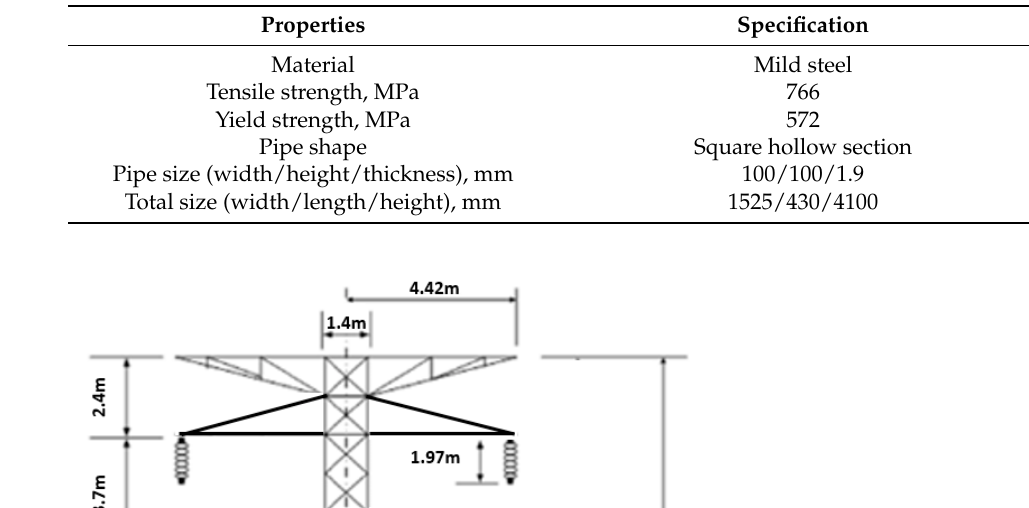
Table 1. Specification of material of creep test rig [19].